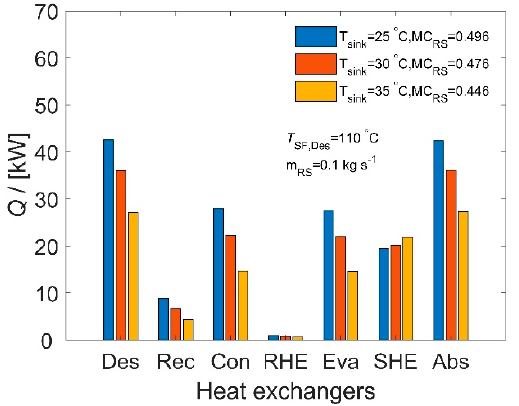
Figure 17. Heat exchanger loads as a function of heat sink temperature.